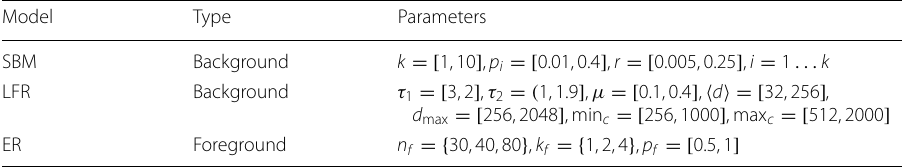
Number of nodes is represented by N = 4000 . SBM parameters are: k represents the number of communities, p i the edge probability for within-community i , r the across-community edge probability, such that p i > r . LFR parameters are: τ 1 , τ 2 skewness parameters for degree and cluster size distributions respectively, (cid:31) d (cid:30) represents the average network degree, d min , d max represent the min and max values of degree distribution, min c and max c represent the sizes of smallest and largest clusters, and finally n f , k f , p f represent the size of the foreground subnetwork, number of foreground subnetworks and its edge probability,